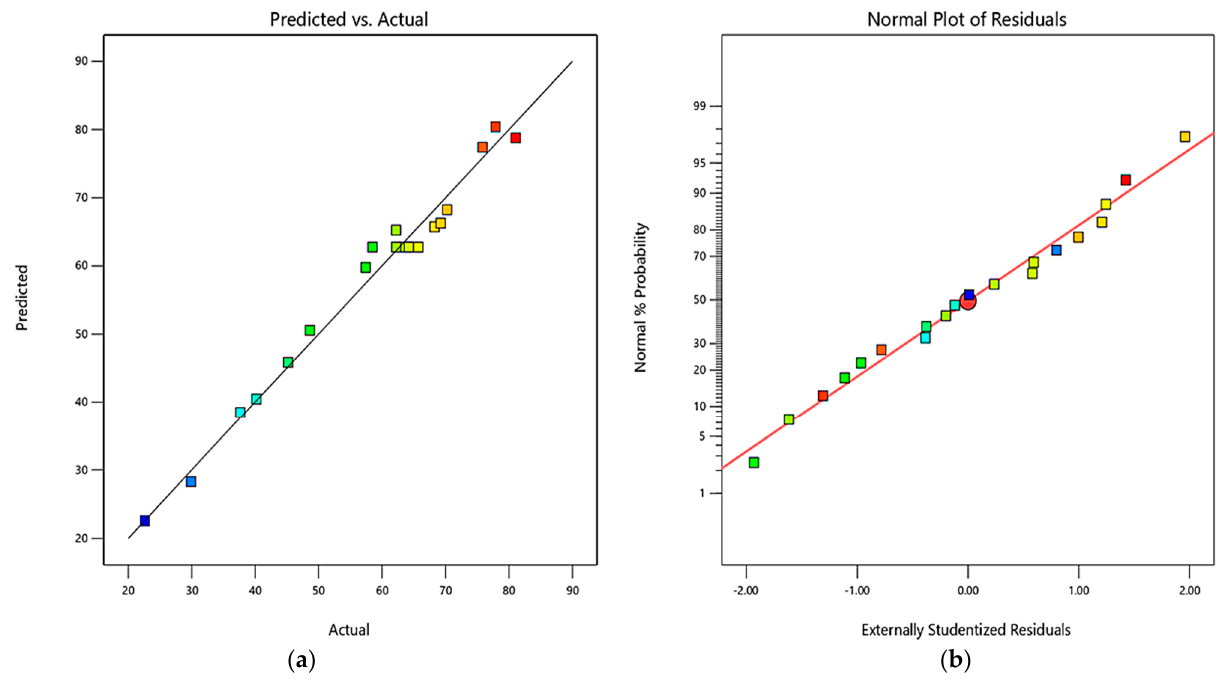
Figure 2. Plot of ( a ) Normal residuals and ( b ) Predicted vs. Actual Response.